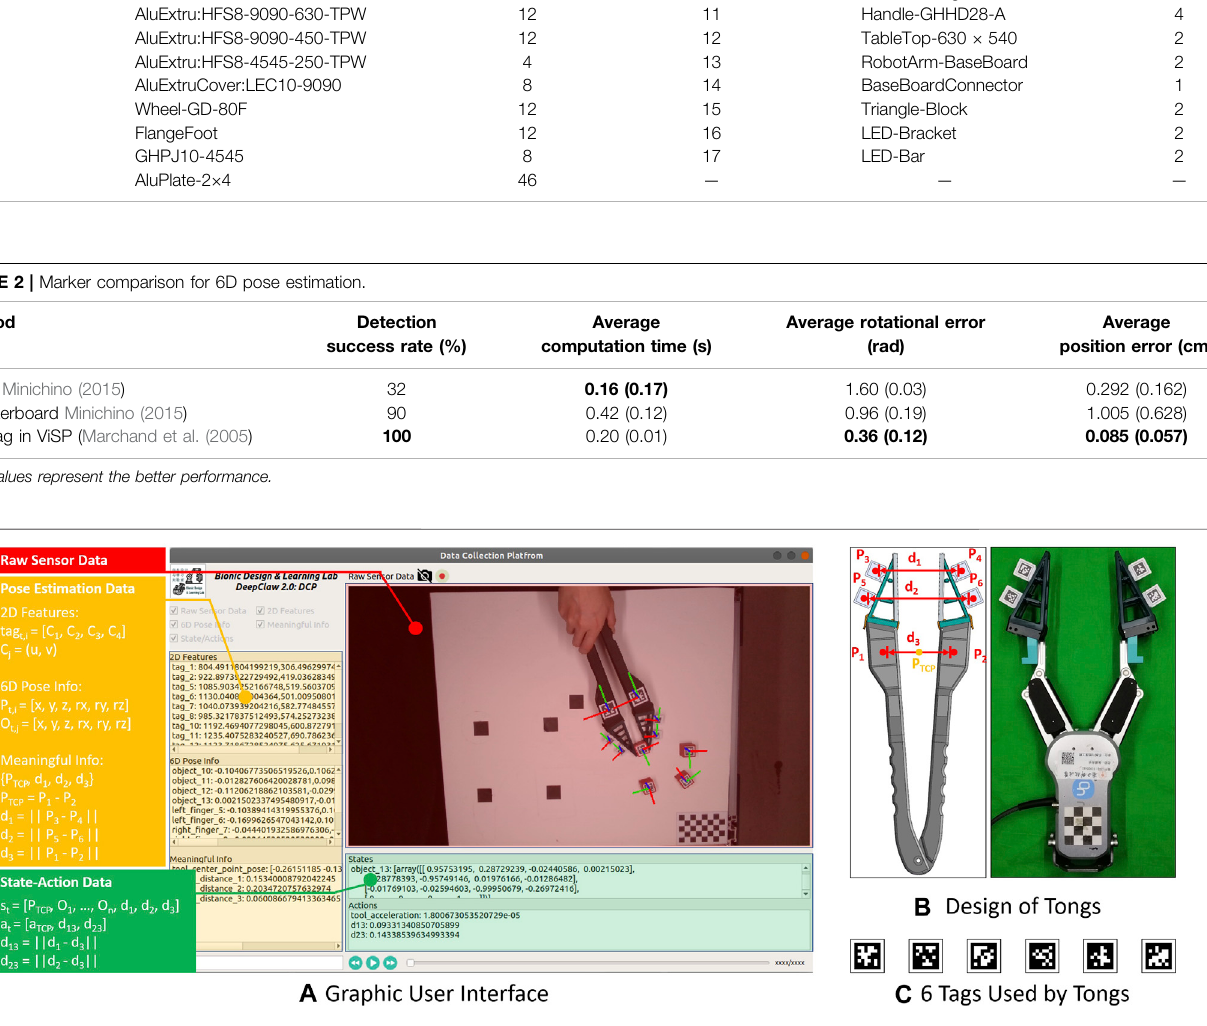
TABLE 1 | Bill of materials for DeepClaw 2.0.